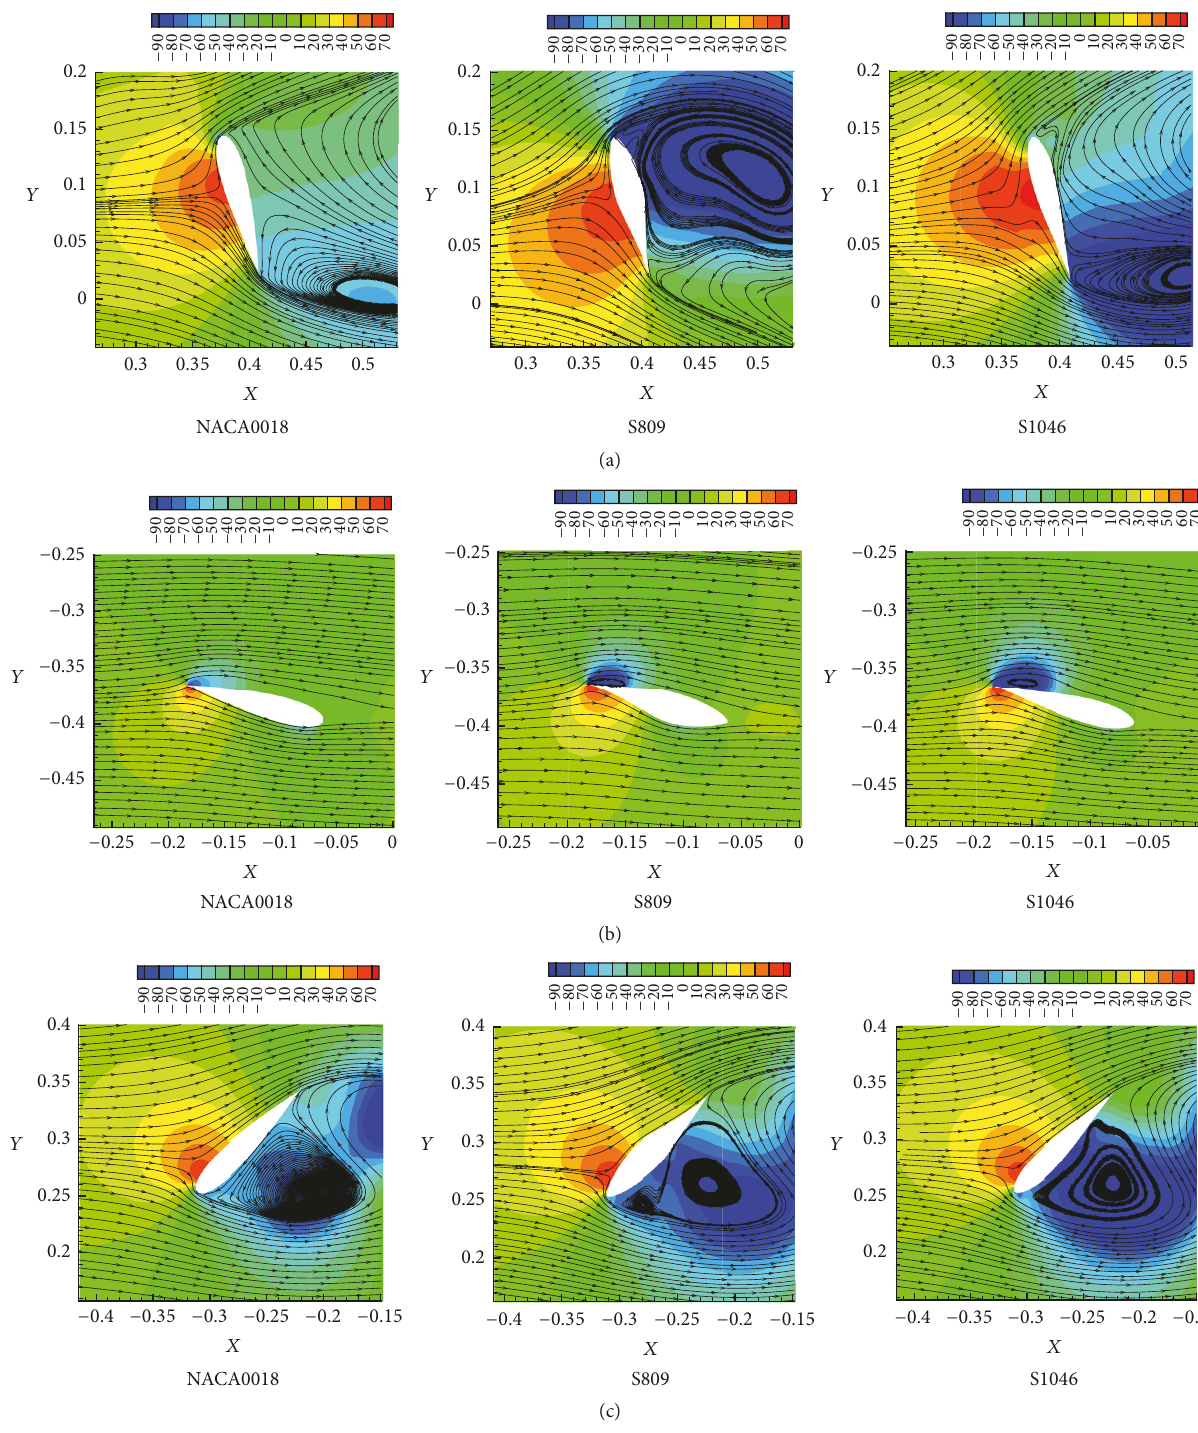
Figure 16: Flow fields around blade with different airfoils ( 𝜃 = 45 ∘